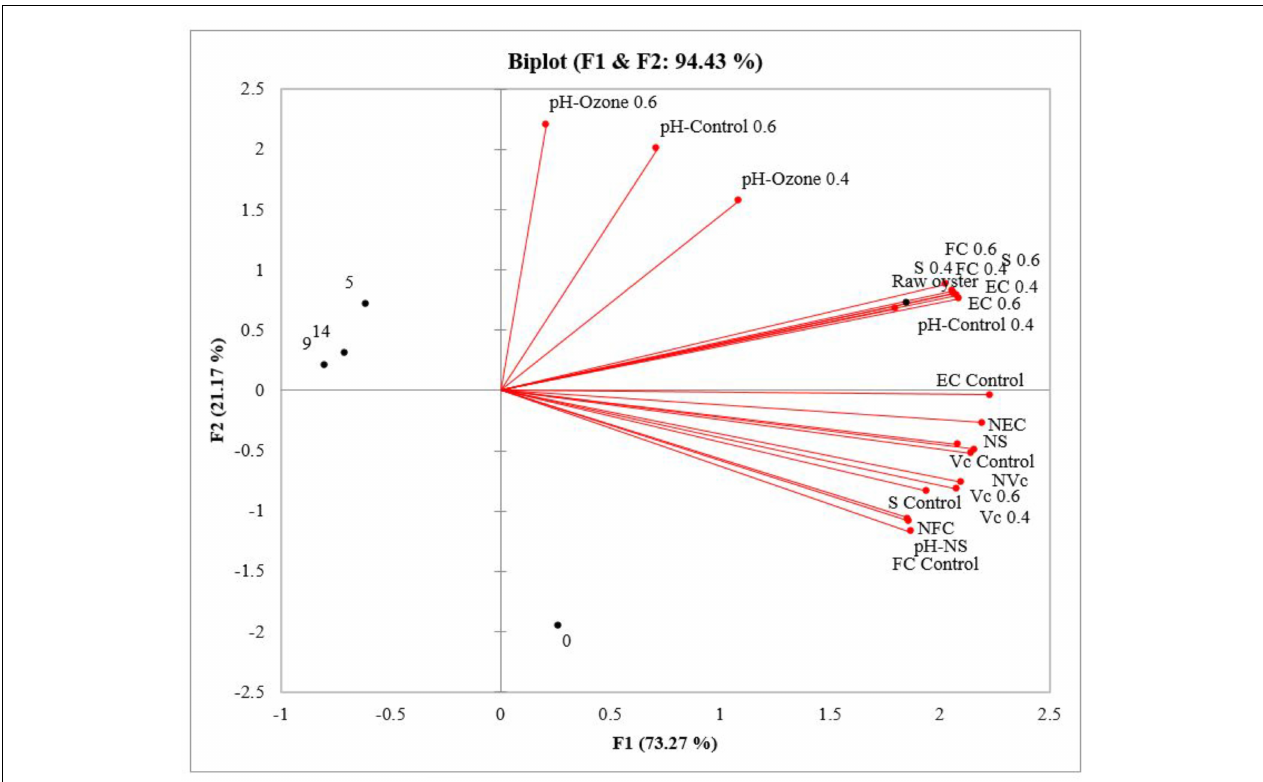
FIGURE 3 | Principal Component Analysis (PCA) projections of scores and loadings for the first two principal components for the analysis of densities of fecal coliforms (FC), E. coli (EC), Salmonella spp. (S), and V. cholerae non-O1/non-139 (Vc) and pH in the raw oyster and control samples, nonozonated- superchilled (N), ozonated- superchilled (0.4 and 0.6 mg/L), and the time of superchilled storage (0, 5, 9, and 14 days). Variables with vectors projected in the same plane may be considered as positively